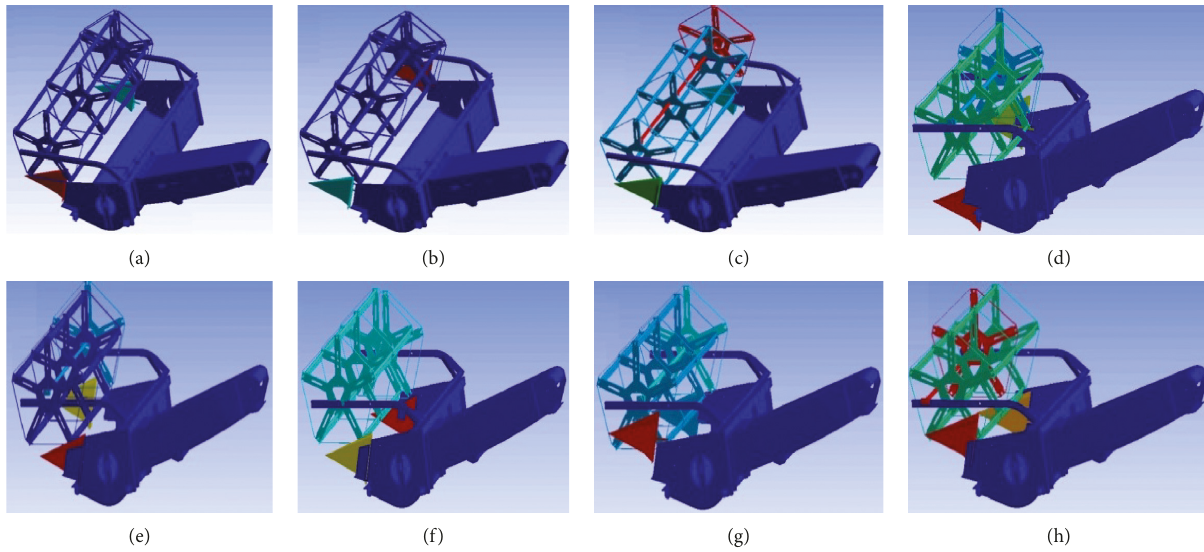
Figure 16: Modal shapes under restricted modality. (a) 1st modal shape. (b) 2nd modal shape. (c) 3rd modal shape. (d) 4th modal shape. (e) 5th modal shape. (f) 6th modal shape. (g) 7th modal shape. (h) 8th modal